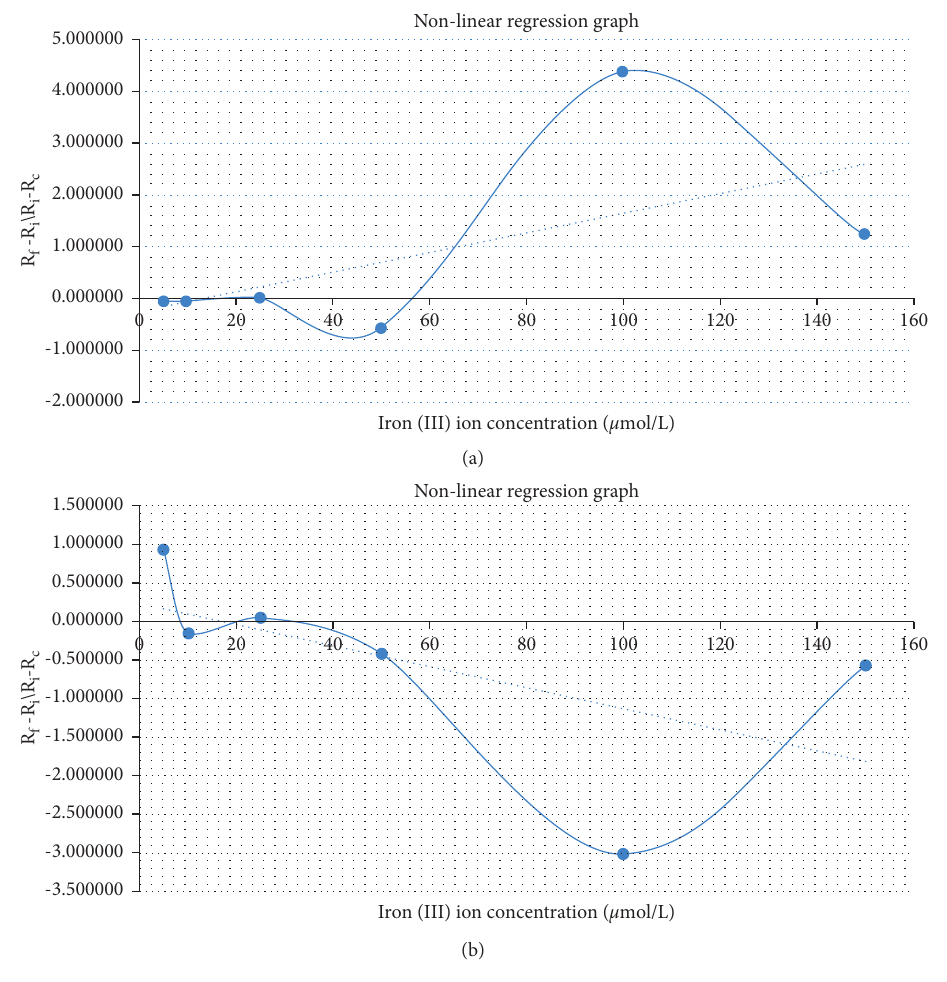
Figure 3: Binding curve showing (a) transferrin-Fe 3+ and (b) apotransferrin-Fe 3+ interactions using nonlinear regression analysis. Ri and Rf represent the mobility ratios of proteins ( t eof / t prot ) recorded in the presence and absence of metal ions at different concentrations, re- spectively. Rc represents the mobility ratio of the protein ( t eof / t prot ) measured at a saturated concentration of metal ion (250 μ